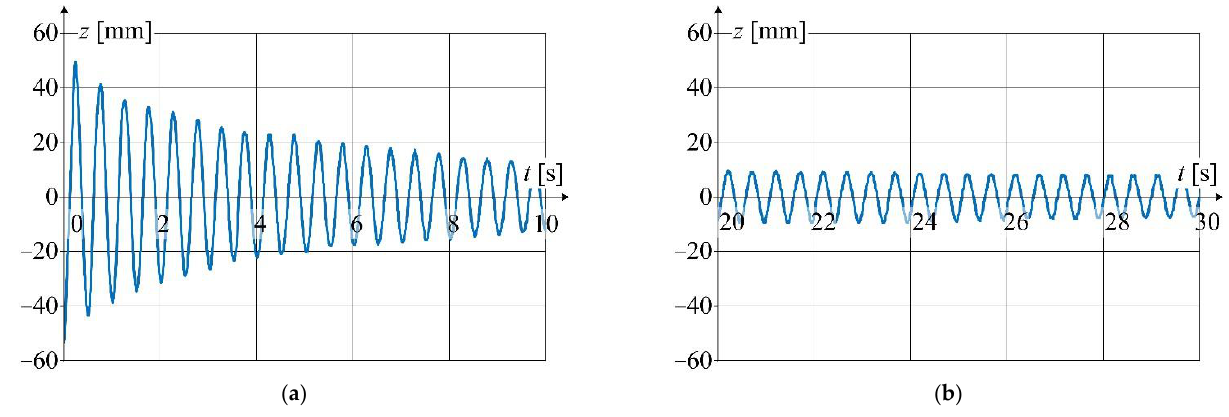
Figure 14. Detailed graphs of displacement waveform (Figure 13): ( a ) for the first 10 s of oscillation; ( b ) for 20 to 30 s of oscillation time. ( b ) for 20 to 30 s of oscillation time.